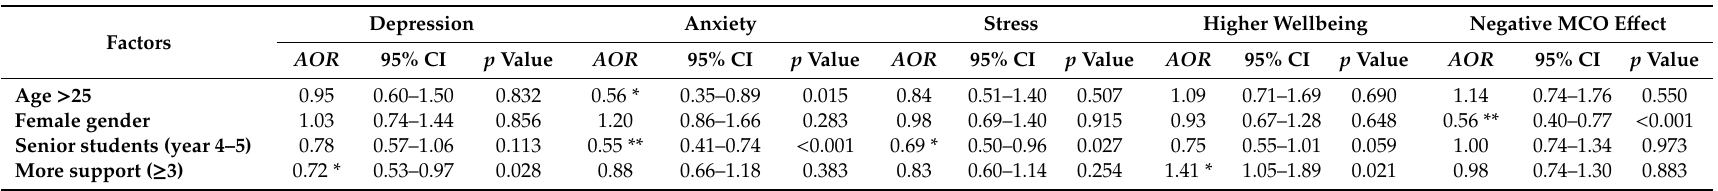
Table 5. Associations between students’ characteristics and social support and depression, anxiety, stress, high wellbeing, and the MCO e ff ect.